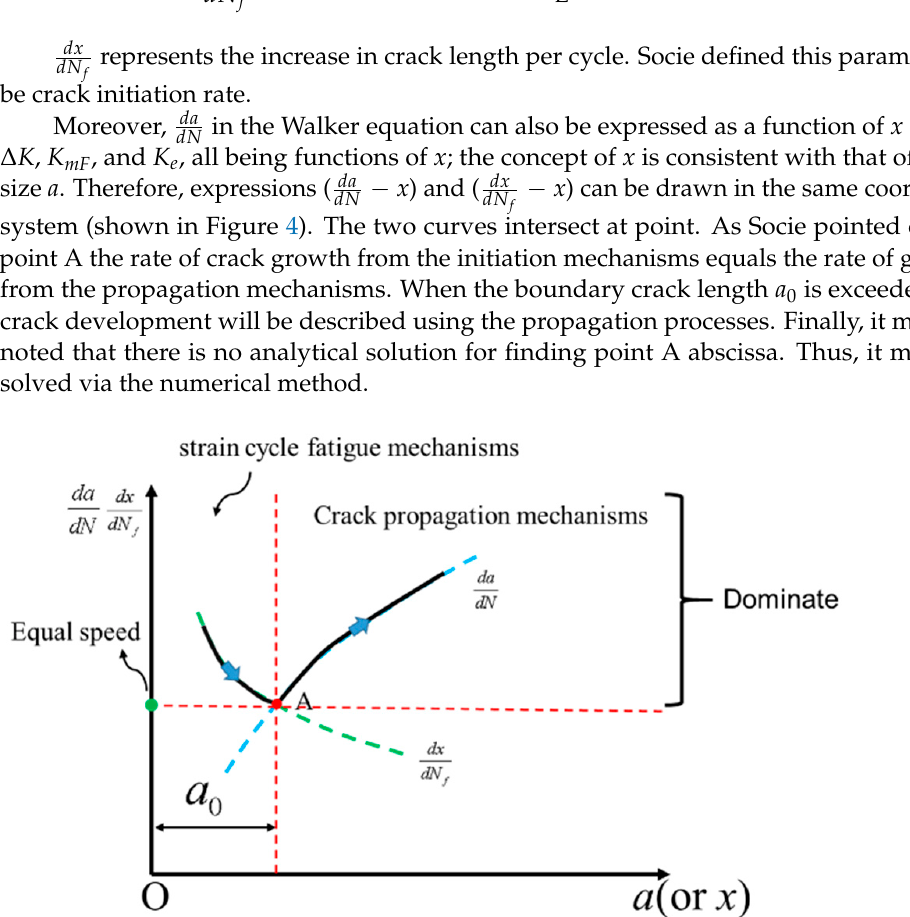
Figure 3. Cross section of cruciform joint with high stress concentration at the weld toe.